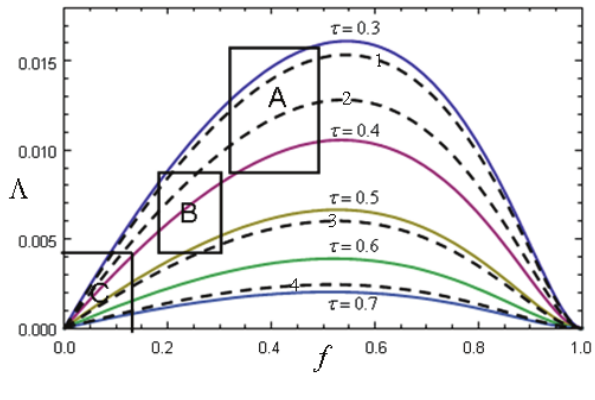
Figure 10. (cid:3) versus fractional fuel cost for several values of τ . Regions A corresponds to coal-gas power plants. Region B corresponds to nuclear power plants and region C to power plants based on renewable sources. The dashed curves 1, 2, 3 and 4, correspond to actual power plants (see end of Section